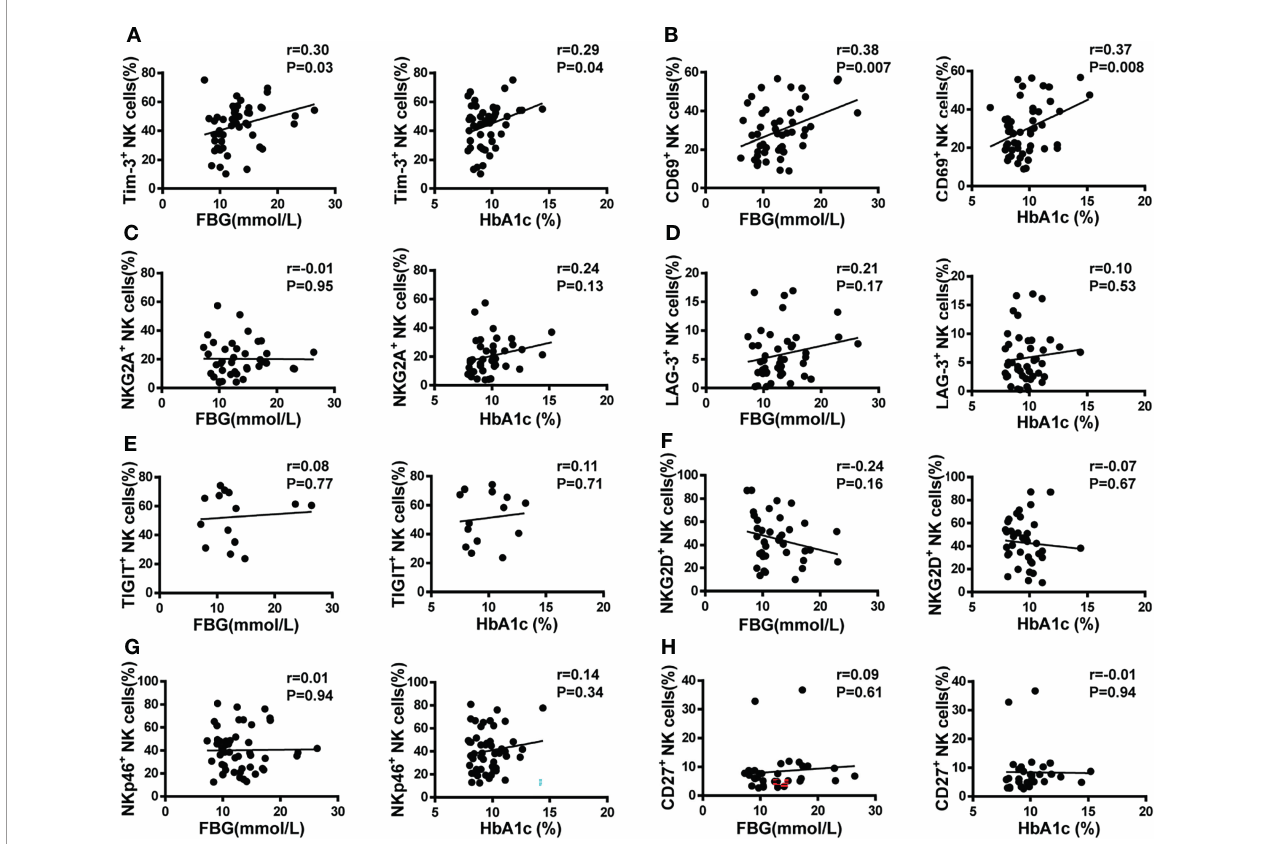
FIGURE 4 | Pearson ’ s correlation analysis of NK cell receptor expression, fasting blood glucose (FBG), and glycosylated hemoglobin (HbA1c) in T2DM patients. (A) Scatter plot graphs indicating positive correlation between Tim-3 + expression and both FBG and HbA1c. (B) CD69 + NK cells were positively correlated with both FBG and HbA1c. No correlation was detected between the percentage of NKG2A + (C) , LAG-3 + (D) , TIGIT + (E) , NKG2D + (F) , NKp46 + (G) , and CD27 + (H) NK cells and either FBG or HbA1c.